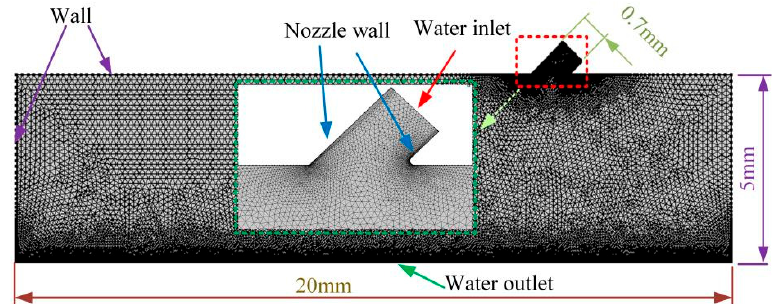
Figure 6. Two-dimensional model and meshing.